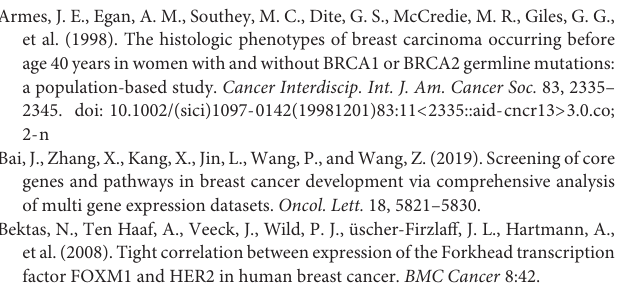
Supplementary Figure 1 | Diagram of the Short Tandem Repeats used for the haplotype analysis. This map is based on the information provided by UniSTS, UCSC. The location and order of the loci used in the present study, as well as their physical and genetic positions are shown. These data are extracted from the Marshfield genetic map (Marshfield Center for Medical Genetics). Supplementary Figure 2 | Assessment of the stereochemical (A) and local (B) qualities of hRAD50 homology model in comparison with the template structure by establishing the Ramachandran Plot and the Verif3D profile